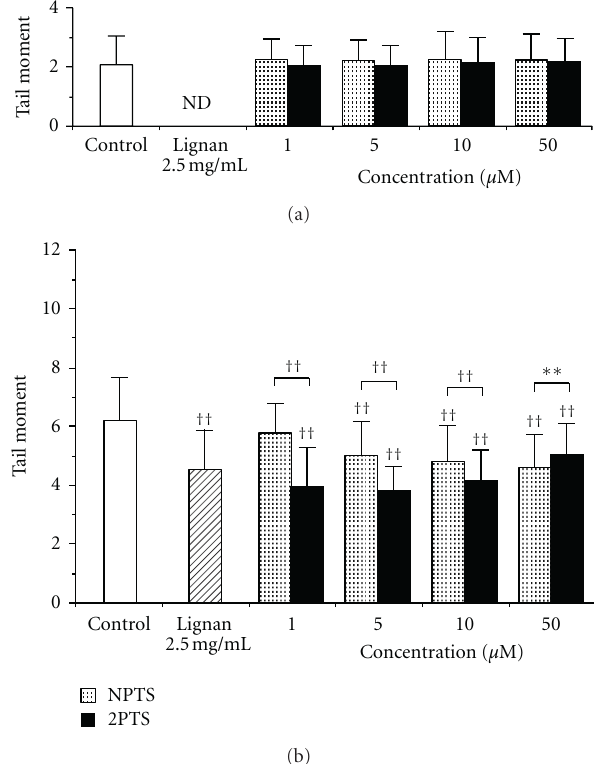
Figure 2: The e ff ect of alk(en)yl thiosulfates on X-ray-induced DNA damage in rat hepatoma H4IIE cells. Cells were pretreated with di ff erent concentrations (1–50 µ M) of sodium n -propyl thiosulfate (NPTS), sodium 2-propenyl thiosulfate (2PTS), or 2.5mg/mL lignan-containing flaxseed extract for 48 hours at 37 ◦ C before X-ray irradiation (10 Gy). Control cells (white column) were not exposed to any compound. The experiments were divided into nonirradiated (a) and X-ray-irradiated (b) groups. The assessment of DNA damage was carried out on 50–100 individual cells per treatment using a comet assay. Data were analyzed by a one-way factorial analysis of variance with post hoc tests (Tukey’s method). ∗∗ P < 0 . 01 and †† P < 0 . 001 versus control or between groups. ND: not